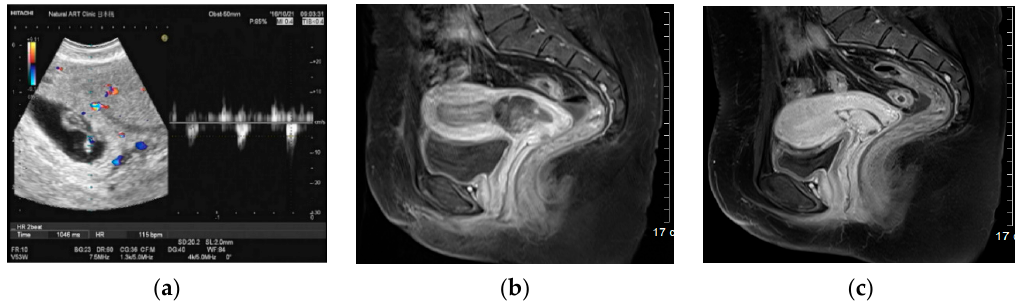
Figure 2. Transvaginal ultrasound Doppler image and pelvic MRI scan of cesarean section scar pregnancy with positive fetal heartbeat. ( a ) Transvaginal ultrasound Doppler image demonstrating FHB-positive CSSP. ( b ) Axial sections of pelvic MRI before the injection; initial serum β-hCG level was 43,596 mIU/mL and that at 2 h after the AE injection was 32,161 mIU/mL, demonstrating a reduction rate of 26.2%. ( c ) Axial sections of pelvic MRI on day 25 of the injection. Serum β-hCG level was 6.8 mIU/mL (on day 38, the level decreased to < 1.0 mIU/mL).